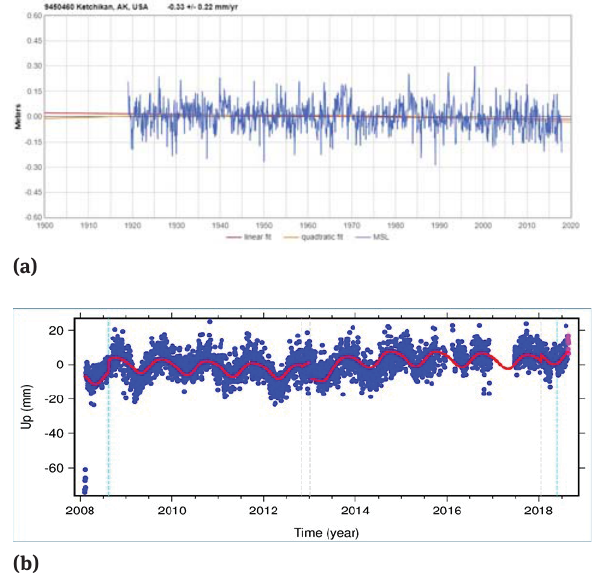
Figure 3: (a) MSL data for Ketchikan, AK, USA. Image reproduced modified after [4]. (b) GNSS time series for AIS6. Image reproduced modified after